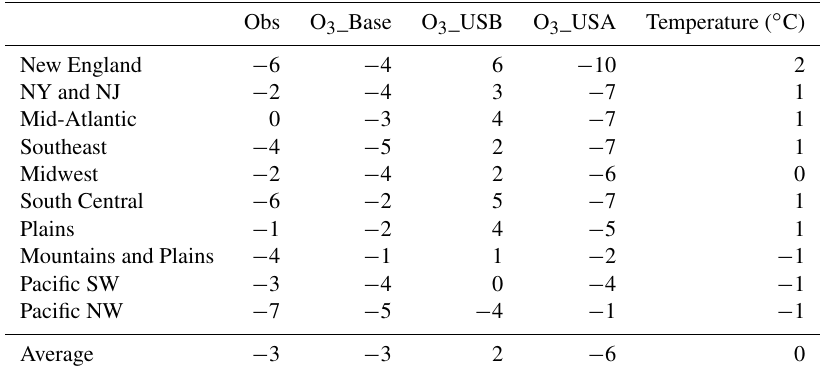
Table 4. Change in MDA8 O 3 concentrations from 2004–2006 to 2010–2012 in the observations, O 3 _Base, O 3 _USB, O 3 _USA, and tem- perature on O 3 _top10obs_JJA